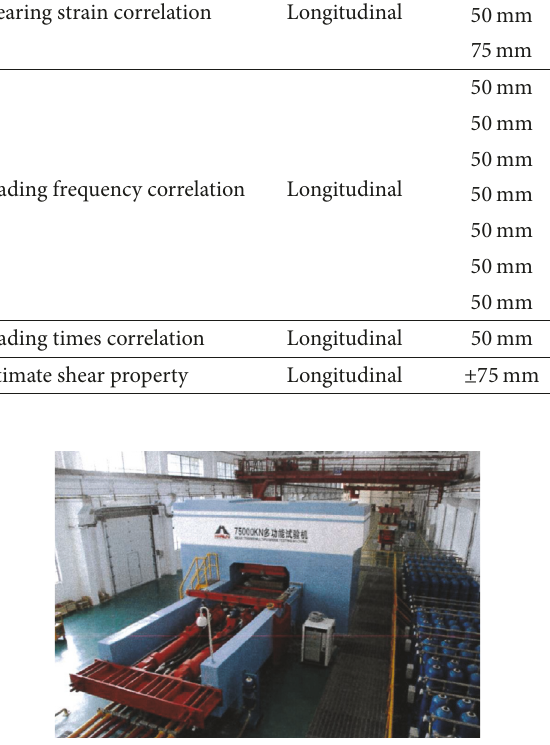
Figure 7: Multifunctional testing